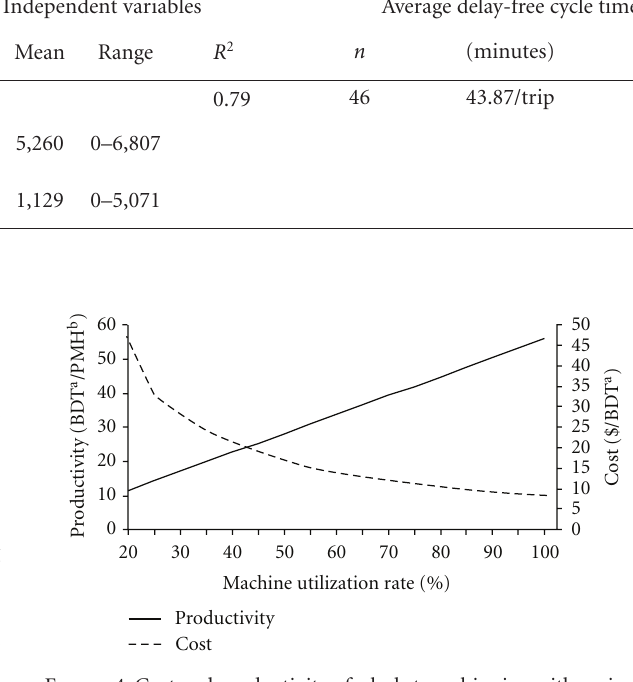
Figure 4: Cost and productivity of whole tree chipping with various utilization rates for associated machinery. ( a BDT: bone dry metric tons; b PMH: productive machine hour; SMH: scheduled machine hour; Utilization = (PMH/SMH) ∗